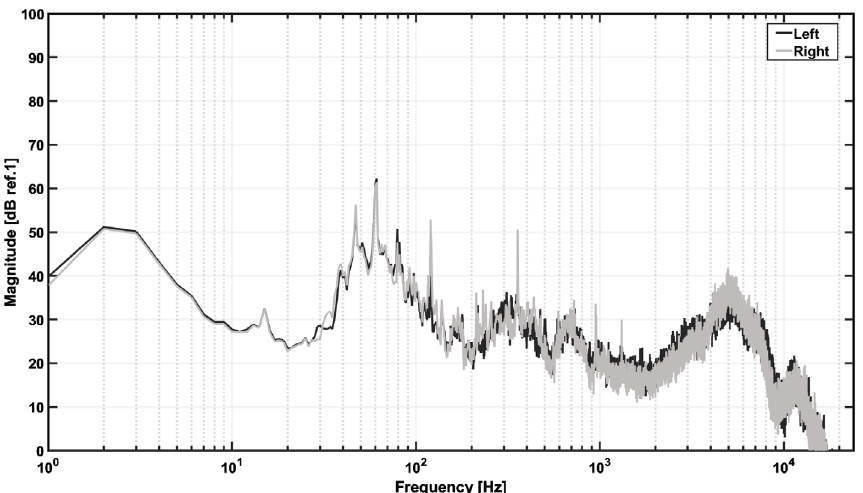
Figure 2. Frequency spectra of the sound environment generated using sound- fi eld reconstruction (SFR) method with wave fi eld synthesis (WFS). The spectra were recorded binaurally using a a head and torso simulator equiped with intra-auricular microphones from an average over 30 s of signal. The grey and black curves correspond respectively to the signal recorded using the right and the left ear of the head and torso simulator.